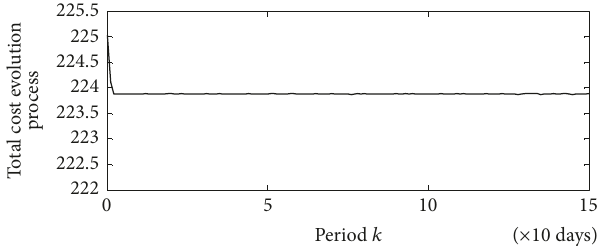
Figure 12: Total cost evolution process under the fuzzy robust strategy ( ×10 8